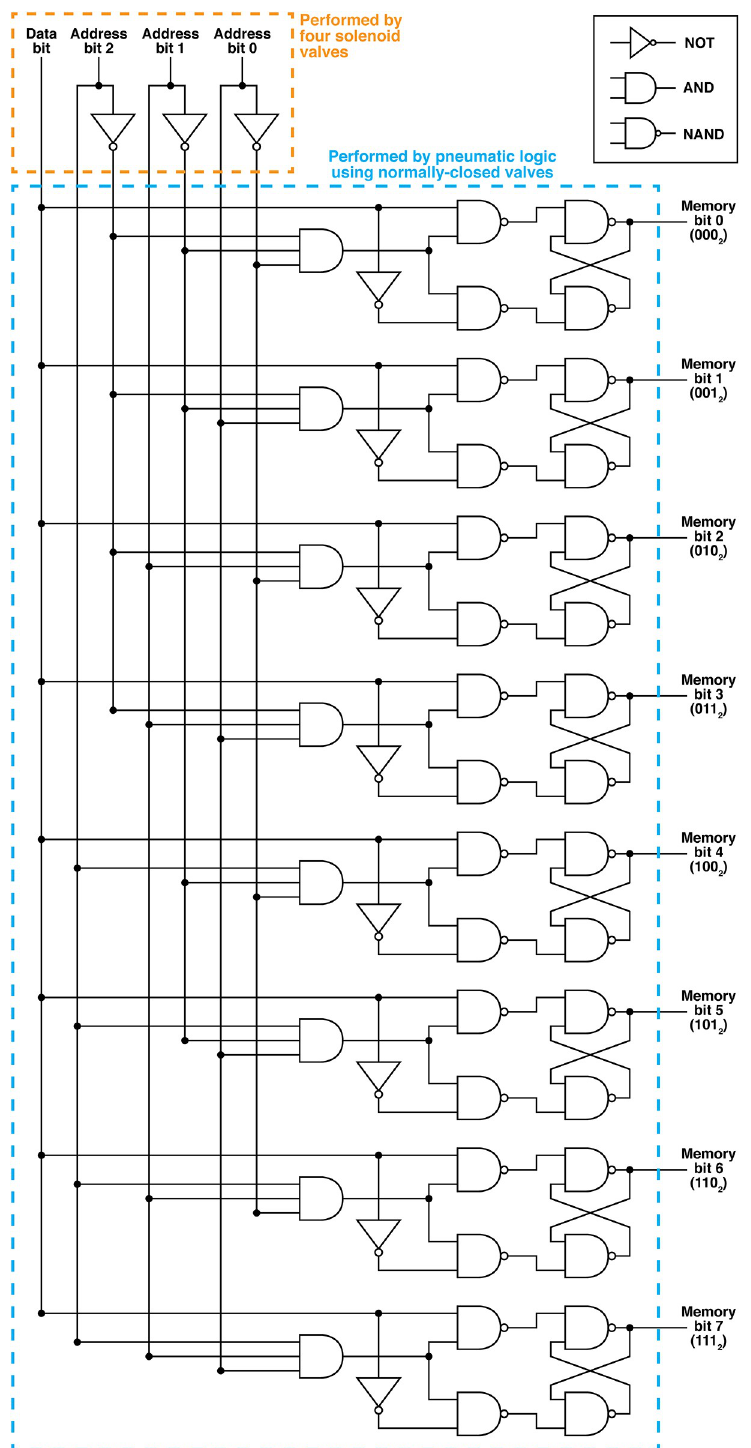
Fig 4. Logic diagram for our pneumatic eight-bit random-access memory. Four solenoid valves (orange region in the diagram) provide three pneumatic Address bits (for selecting which Memory bit to set) and one Data bit (for setting the value of the selected Memory bit); the rest of the logic diagram (blue region) is performed by a pneumatic logic circuit. Eight outputs (labeled Memory bits 0 through 7) provide access to the eight stored pressure levels in the pneumatic RAM and are connected to eight fingers in two soft robotic